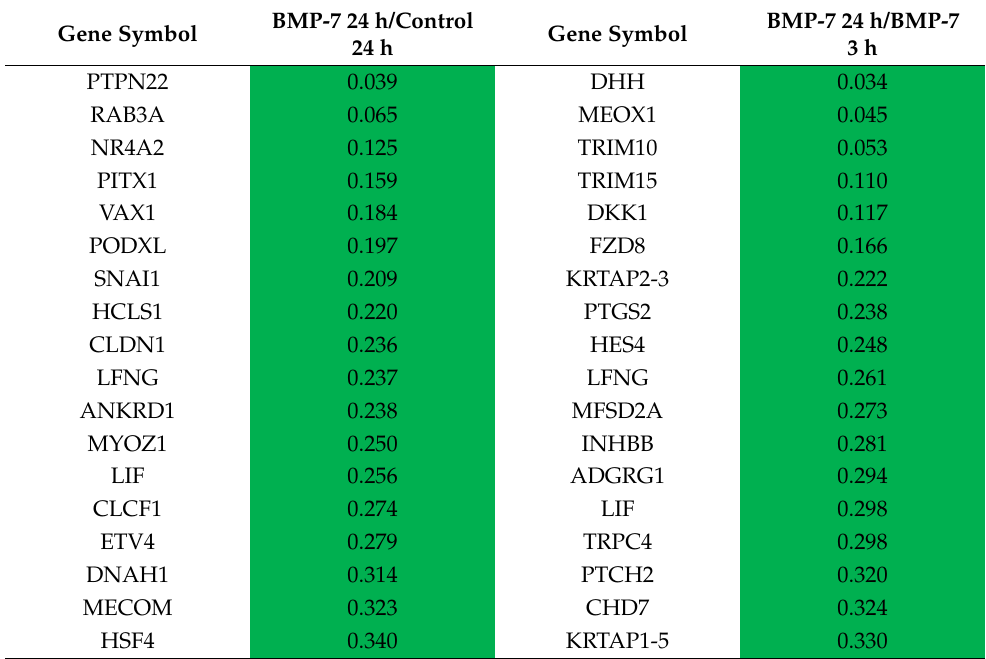
Table 2. Differentially expressed mRNA related to cell differentiation (fold change of greater than 2, log2 normalized data >5 were selected). When comparing gene expression value between samples, the down-regulated gene was shown in green and up-regulated is in